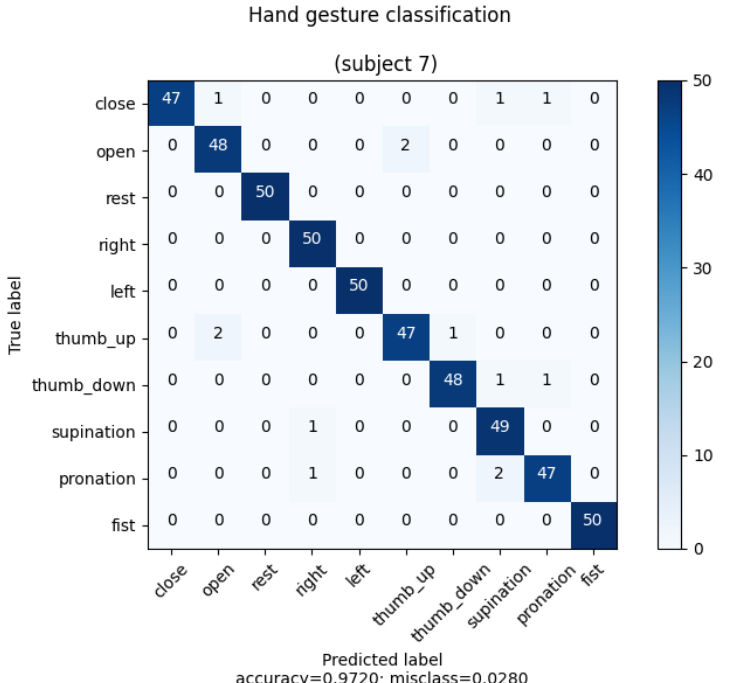
Figure A7. Confusion matrix of a subject who participated in data collection (subject 7).